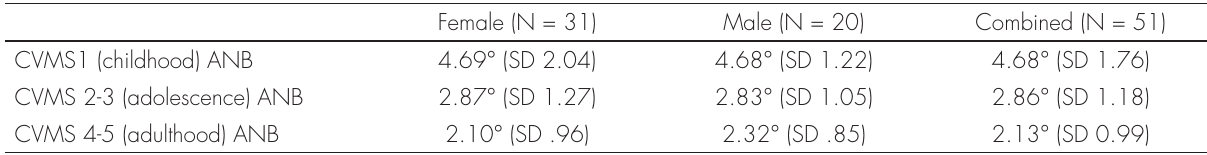
Female childhood and adolescence mean ANB angle difference: Two tailed t -test significant at p < 0.001 Female childhood and adult mean ANB angle difference: Two tailed t -test significant at p < 0.001 Female adolescence and adult mean ANB angle difference: Two tailed t -test significant at p < 0.001 Male childhood and adolescence mean ANB angle difference: Two tailed t -test significant at p < 0.001 Male childhood and adult mean ANB angle difference: Two tailed t -test significant at p < 0.001 Male adolescence and adult mean ANB angle difference: Two tailed t -test significant with p = 0.097 Combined sample childhood and adolescence mean ANB angle difference: Two tailed t -test significant at p < 0.001 Combined sample childhood and adult mean ANB angle difference: Two tailed t -test significant at p < 0.001 Combined sample adolescence and adult mean ANB angle difference: Two tailed t -test significant at p <